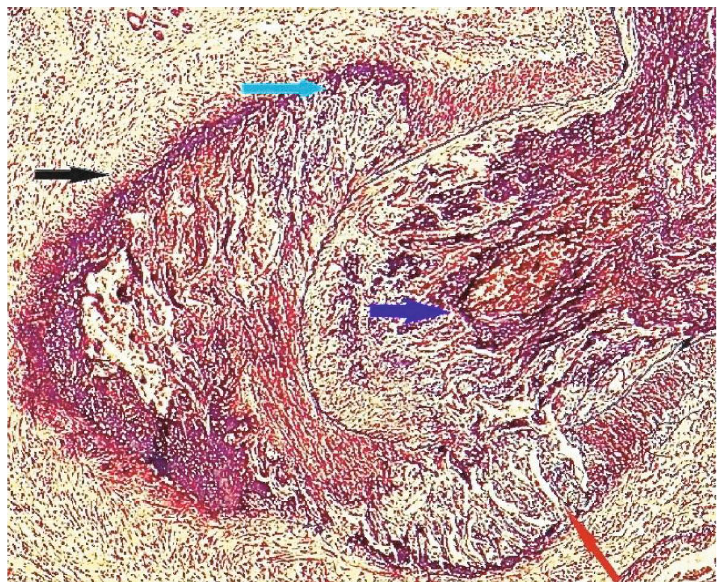
Figure 14: Segmental arterial mediolysis reparative phase. Early reparative change in media and intima. The red arrow points to young granulation tissue fi lling and expanding a focus of transmural mediolysis and extending thru a fragmented internal elastica to form a broad intimal plaque severely narrowing an arterial lumen (blue arrow) already compromised by a recent thrombus. The black arrow points to a markedly outwardly expanded fi brin-lined adventitia outlining an edematous fi brin stranded zone of mediolysis that shows at light blue arrow another focus of granulation tissue. Movat stain × 100 (adapted from the Journal of Cardiovascular Disease and Diagnosis 2015.32, online publication).